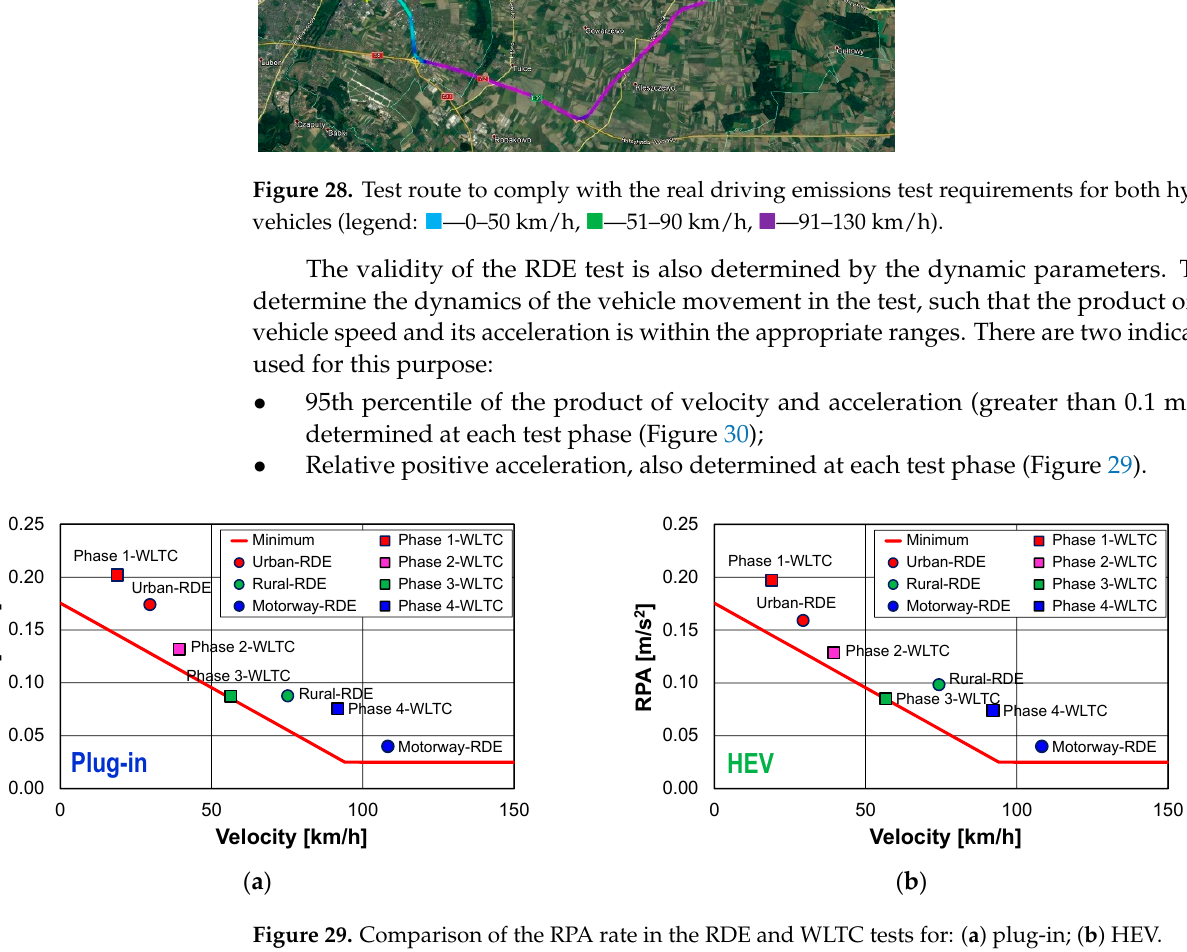
( b ) Figure 31. Carbon dioxide emission rate (E CO2 ) in the RDE test for: ( a ) plug-in; ( b ) HEV.